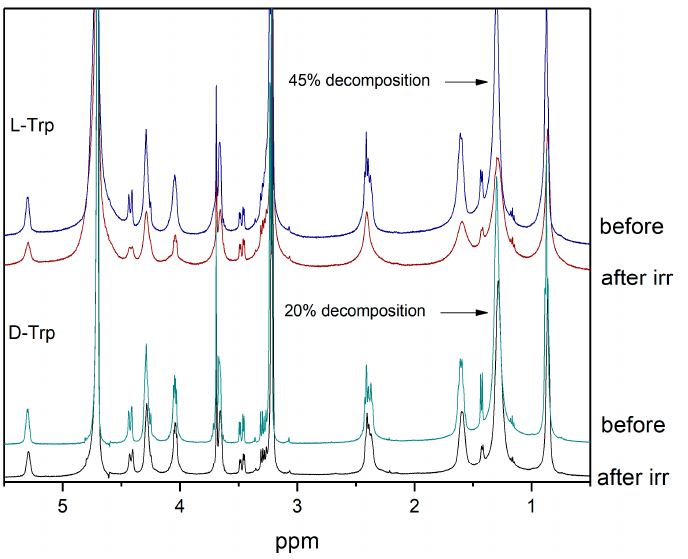
Figure 7. CIDNP spectra detected during photolysis of 2 mM KP in the presence of 4 mM L- and D-tryptophan in PBS at pH 7.4.